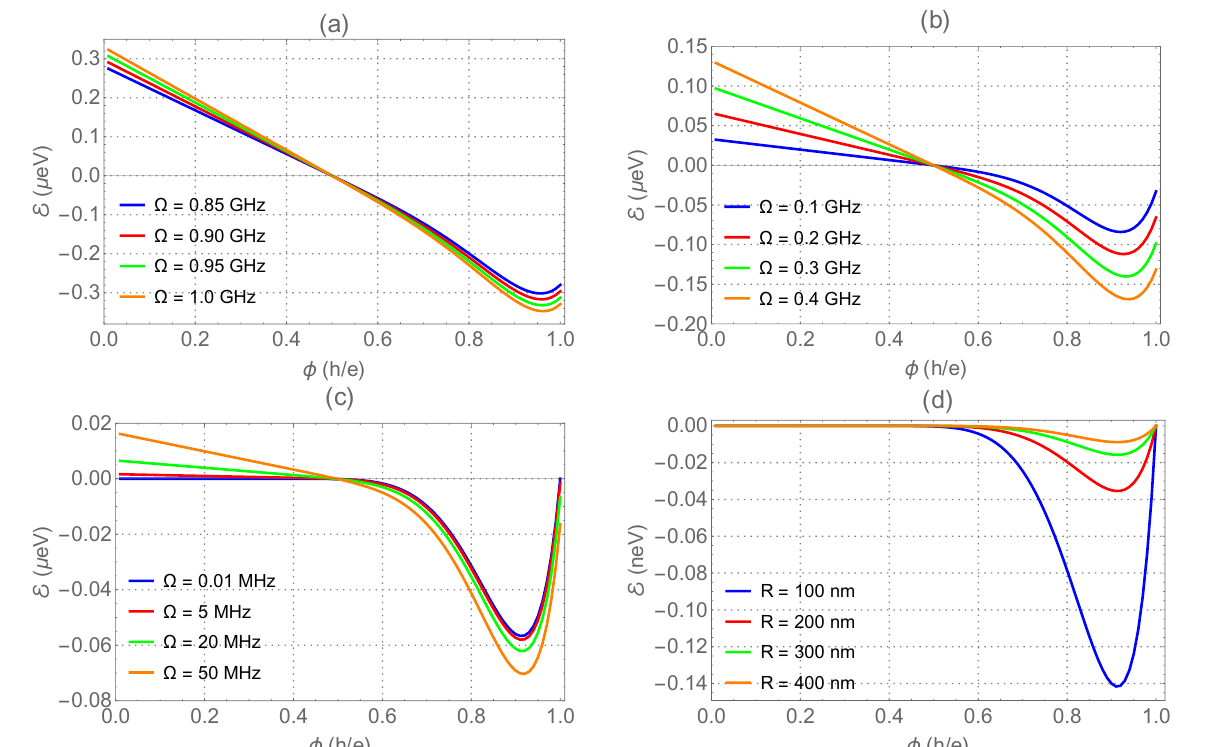
Figure 1. Energy as a function of the flux. In Figure ( a – c ) the profile considering three different frequency ranges for m = 0 and R = 5 nm. In Figure ( d ), we consider some values of R for m = 0 and Ω =